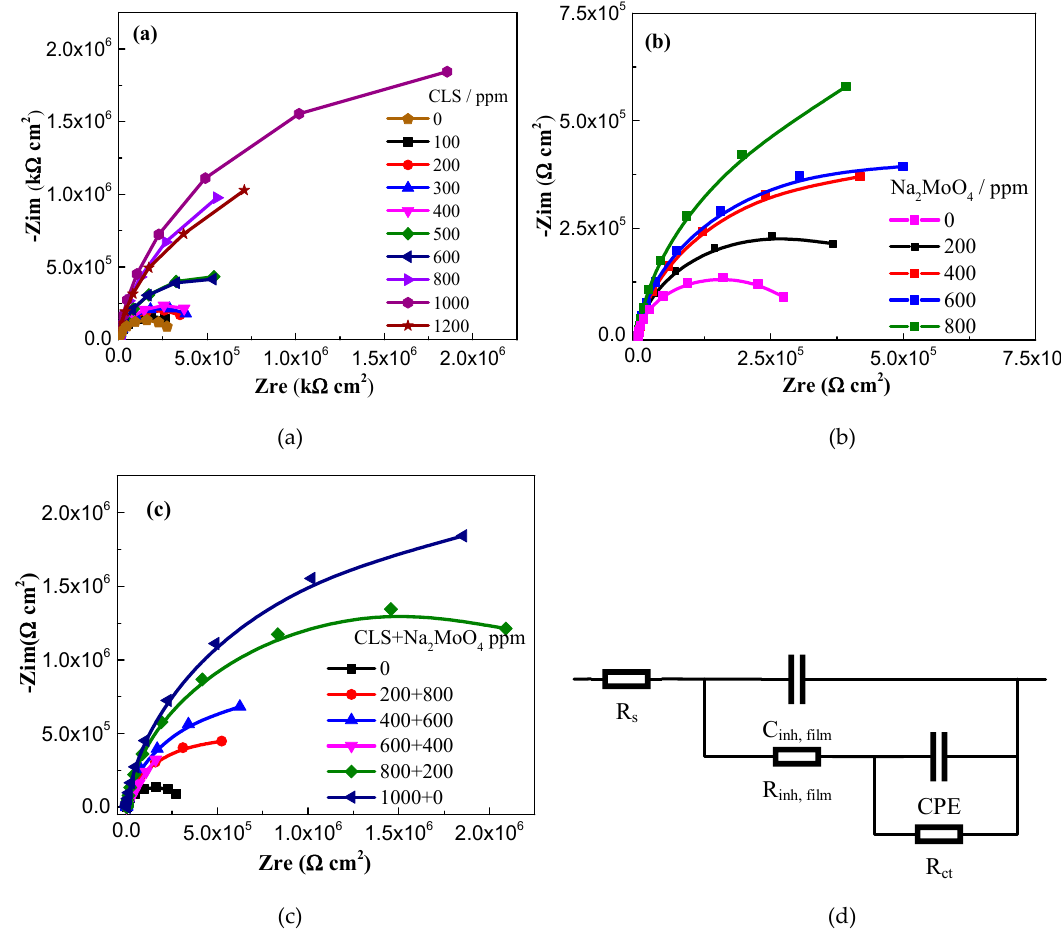
Figure 5. Nyquist plots of Q235 carbon steel in test solutions, ( a ) with CLS; ( b ) with Na 2 MoO 4 ; ( c ) with optimal ratio of CLS and Na 2 MoO 4 ; ( d ) the equivalent circuit.